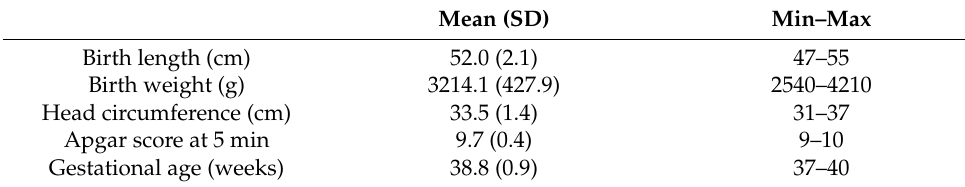
Table 1. Demographic data of 41